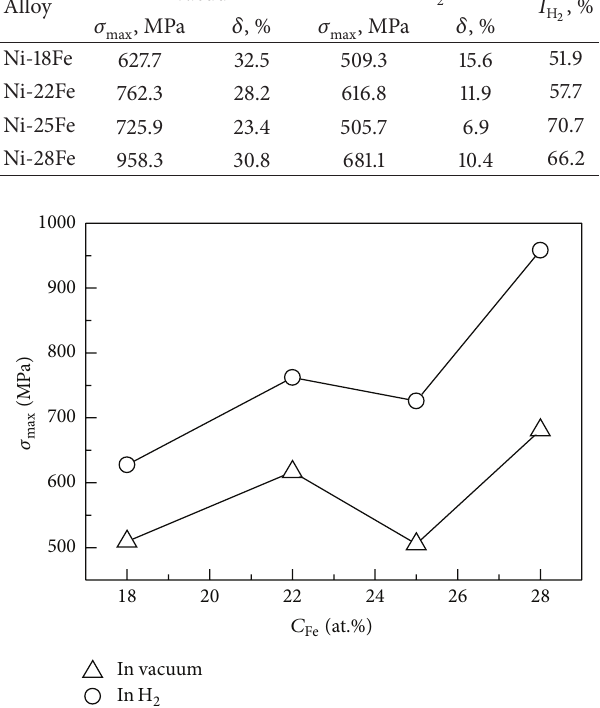
Figure 2: Relationship between the maximum tensile strength and Fe stoichiometry.